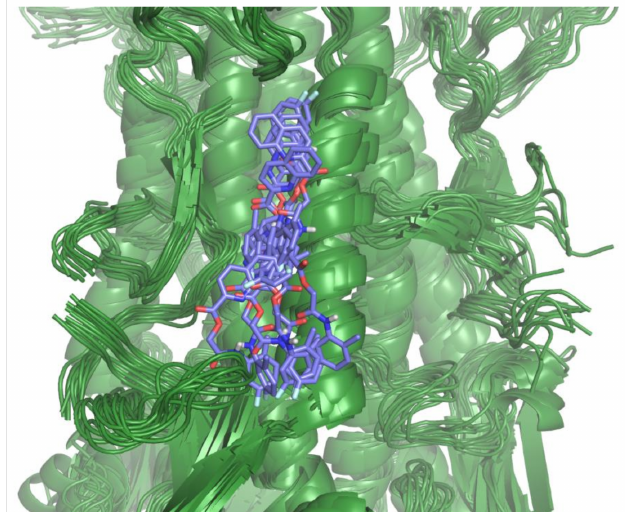
Figure 6. Alignment of the A/Parma/H1N1 HA and compound 4 complexes obtained after clustering the MD trajectory frames. Cluster representatives are